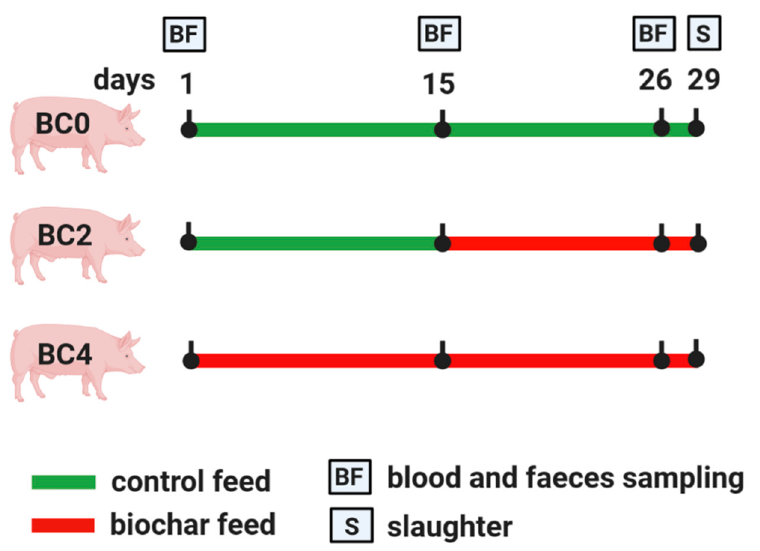
Figure 1. Overview regarding experimental procedure and sampling collection.